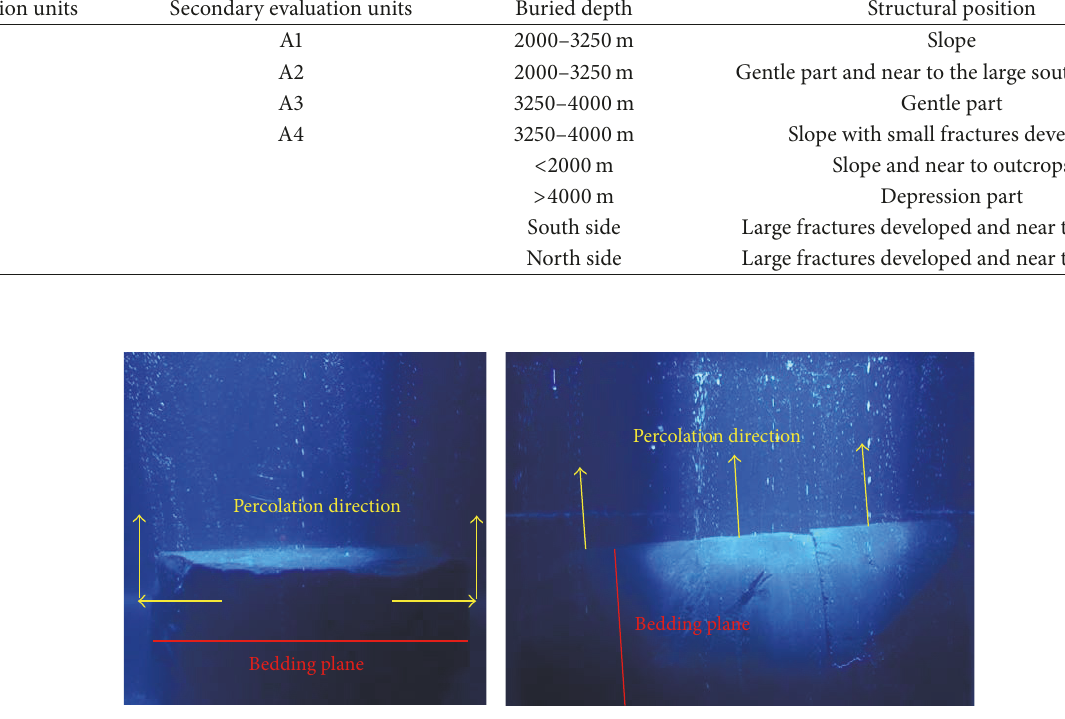
Figure 5: Core immersion test of Lower Silurian, from Well JiaoYe1, Jiaoshiba. See Figure 1 for the location.